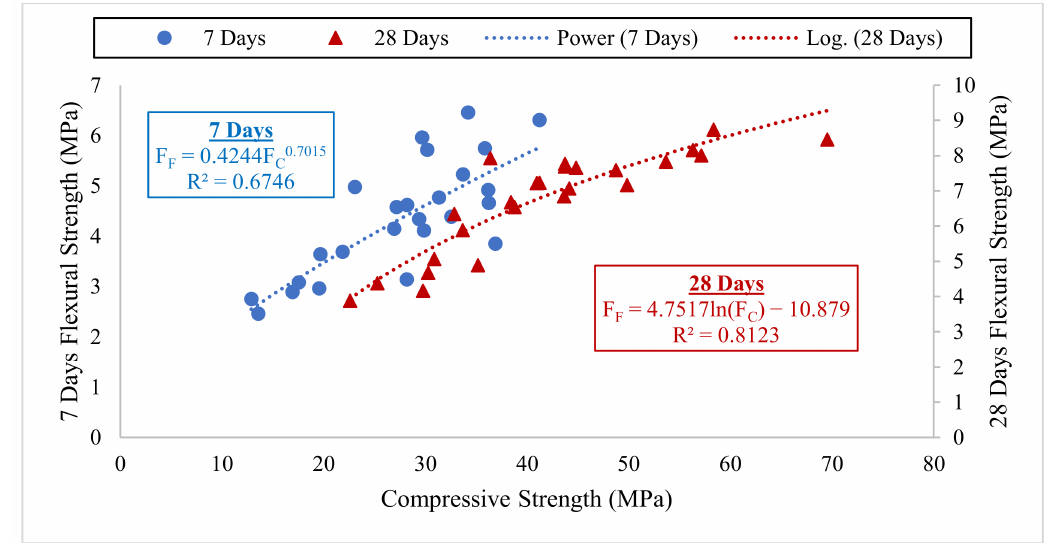
Figure 11. Relationship between Flexural strength and compressive strength.